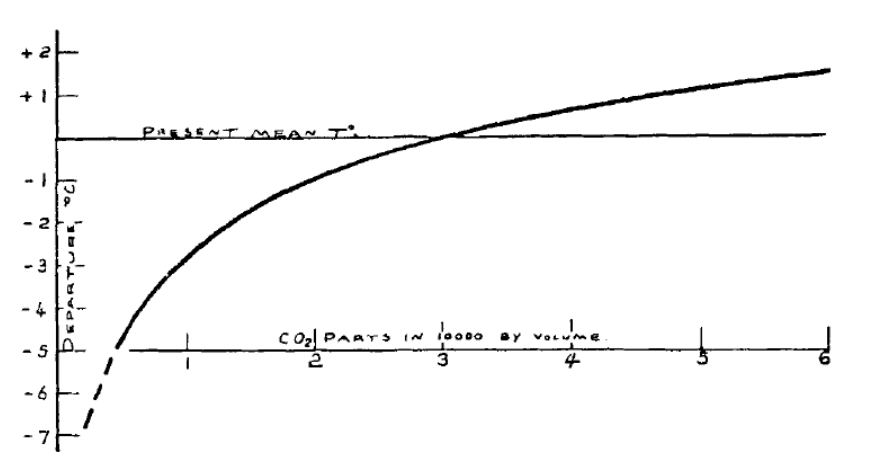
Fig. 1. The effect of atmospheric CO